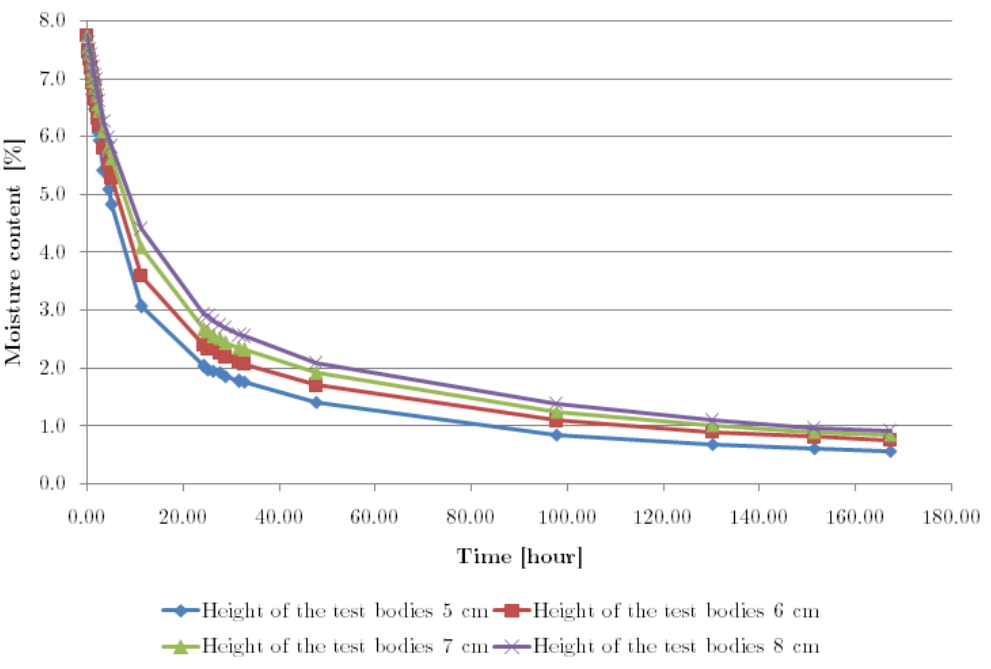
Figure 11. The time course of the moisture content.